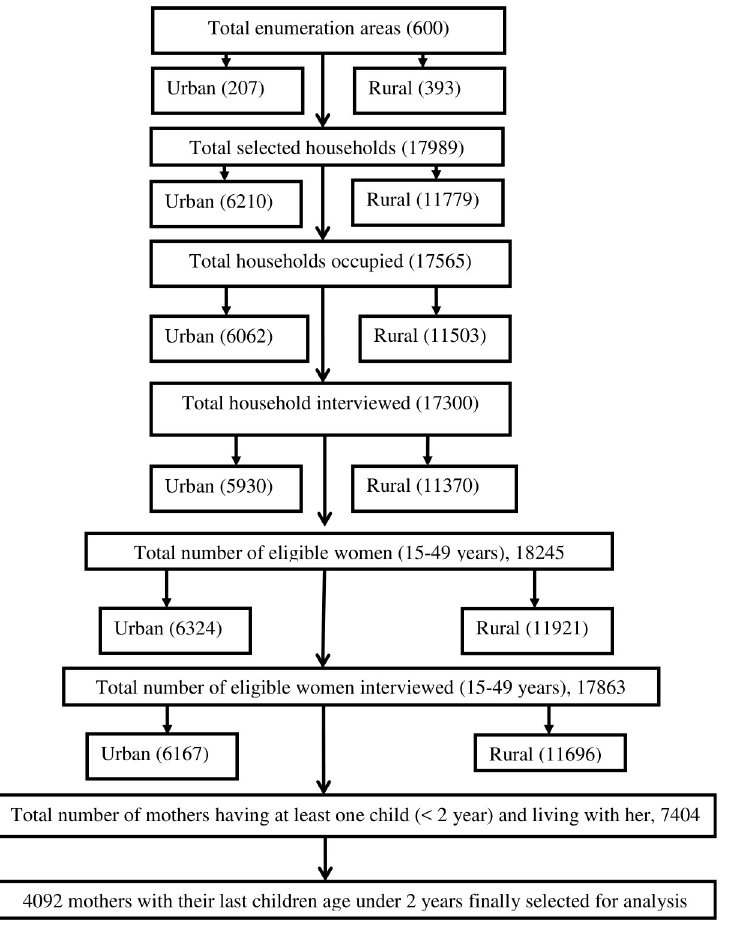
Fig 1. Sample selection procedure for